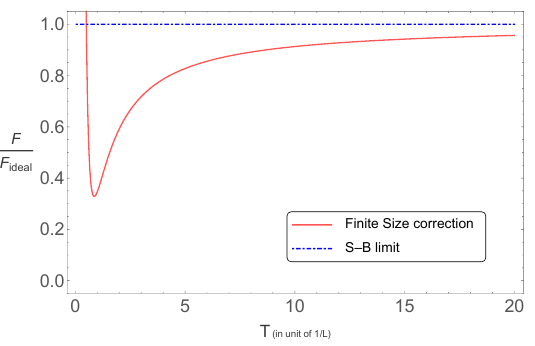
Figure 4. Correction to the free energy of a system at temperature T due to the compactification along one direction with length L . The result is normalized to its non-compactified, non-interacting limit, and plotted as a function of T in unit of 1/ L .